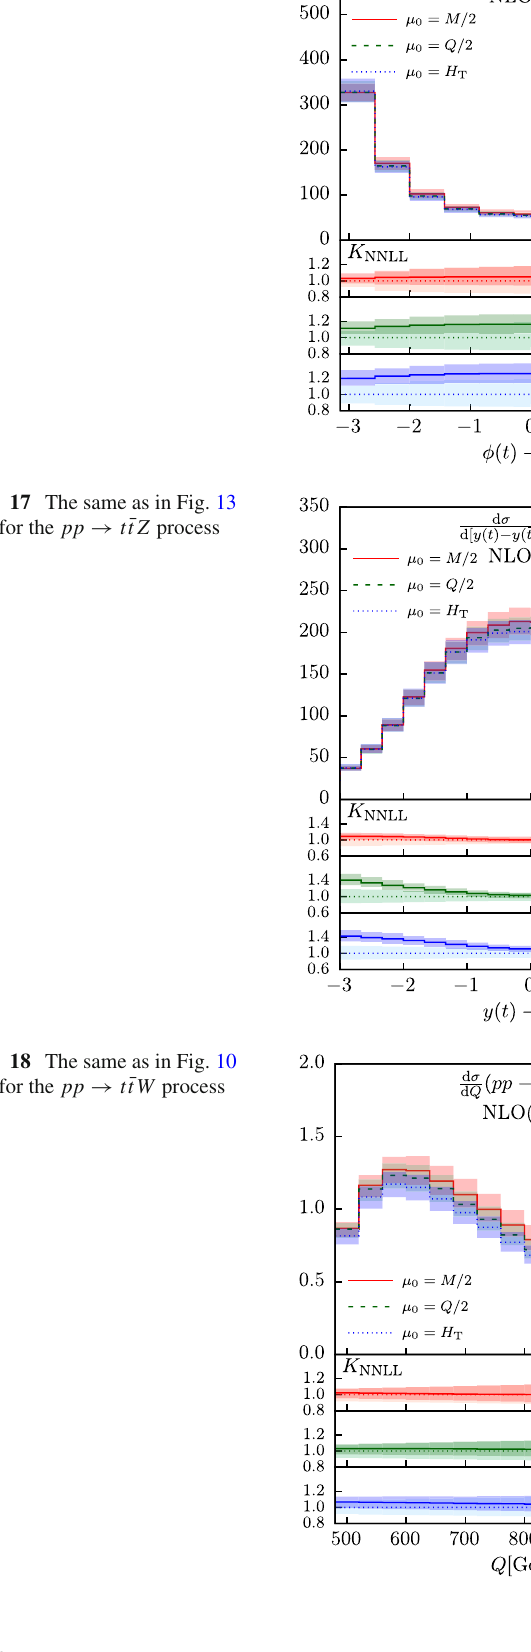
Fig. 16 The same as in Fig. 12 but for the pp → t ¯ tZ process